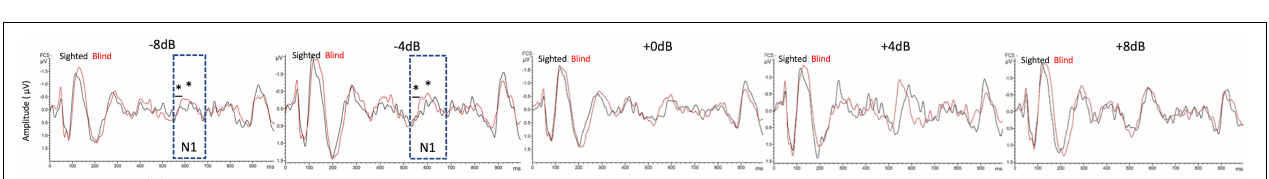
FIGURE 4 | Digit span test. The total score and maximum digit number were significantly higher in the blind group than in the sighted group ( p = 0.010 and p = 0.021, respectively).